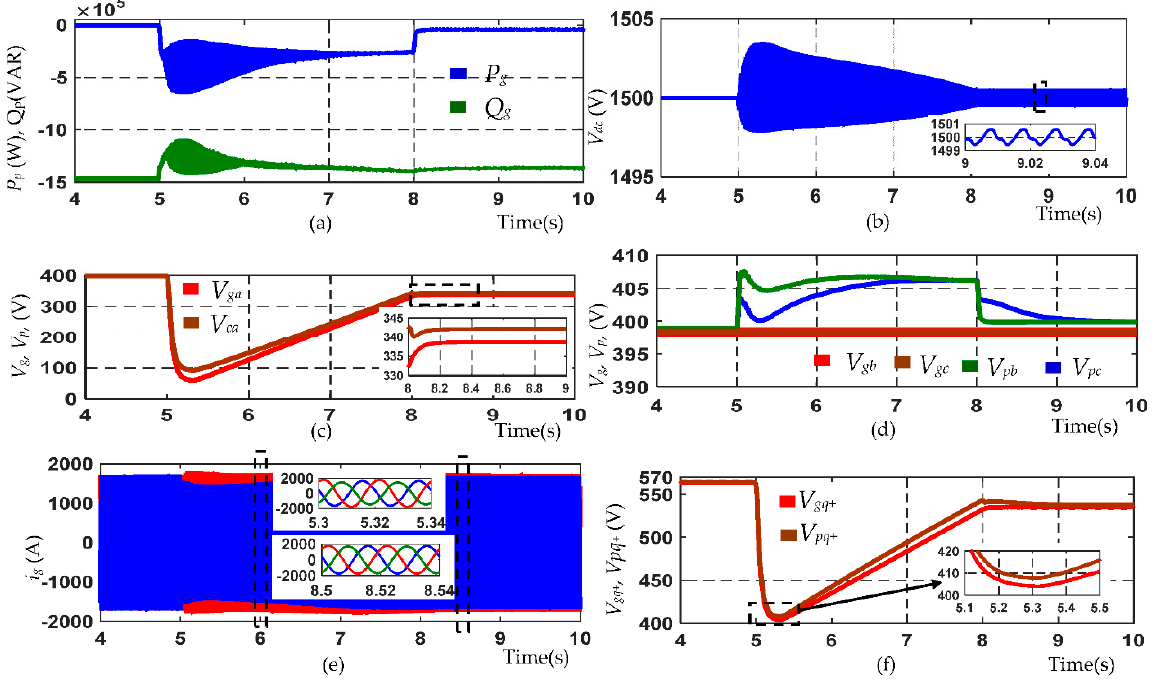
Figure 7 . Performance analysis during single-phase to ground fault (dashed square represents the zoomed-in view): ( a ) grid active (W) and reactive power (VAR); ( b ) DC-link voltage (V); ( c ) grid phase voltages (RMS), (V); ( d ) PCC phase voltages (RMS), (V); ( e ) GSC current, (A); ( f ) PSC of V g and V p (V).